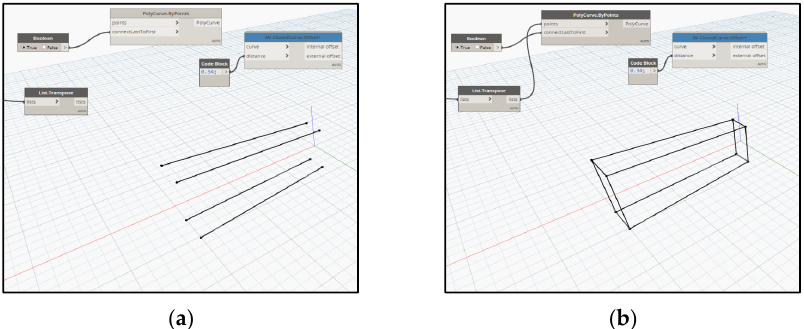
Figure 5. ( a ) PolyCurve.ByPointsnode; ( b ) Connection between the initial the final nodes. TheClosedCurve.Offset + node allows for the production of an offset of the polyline inside or outside, as needed. In the specific case, an internal offset of 0.34 m is made, equal to the height of the vertical stiffening member. To increase the number of polylines, the Number Slide node is used. After drawing the polylines, with the relative offsets, an internal surface through the Surface.ByLoft node is created. The Surface.PerimeterCurves node (Figure 6a,b) divides the surface in correspondence to the external and internal nodes of the polylines.